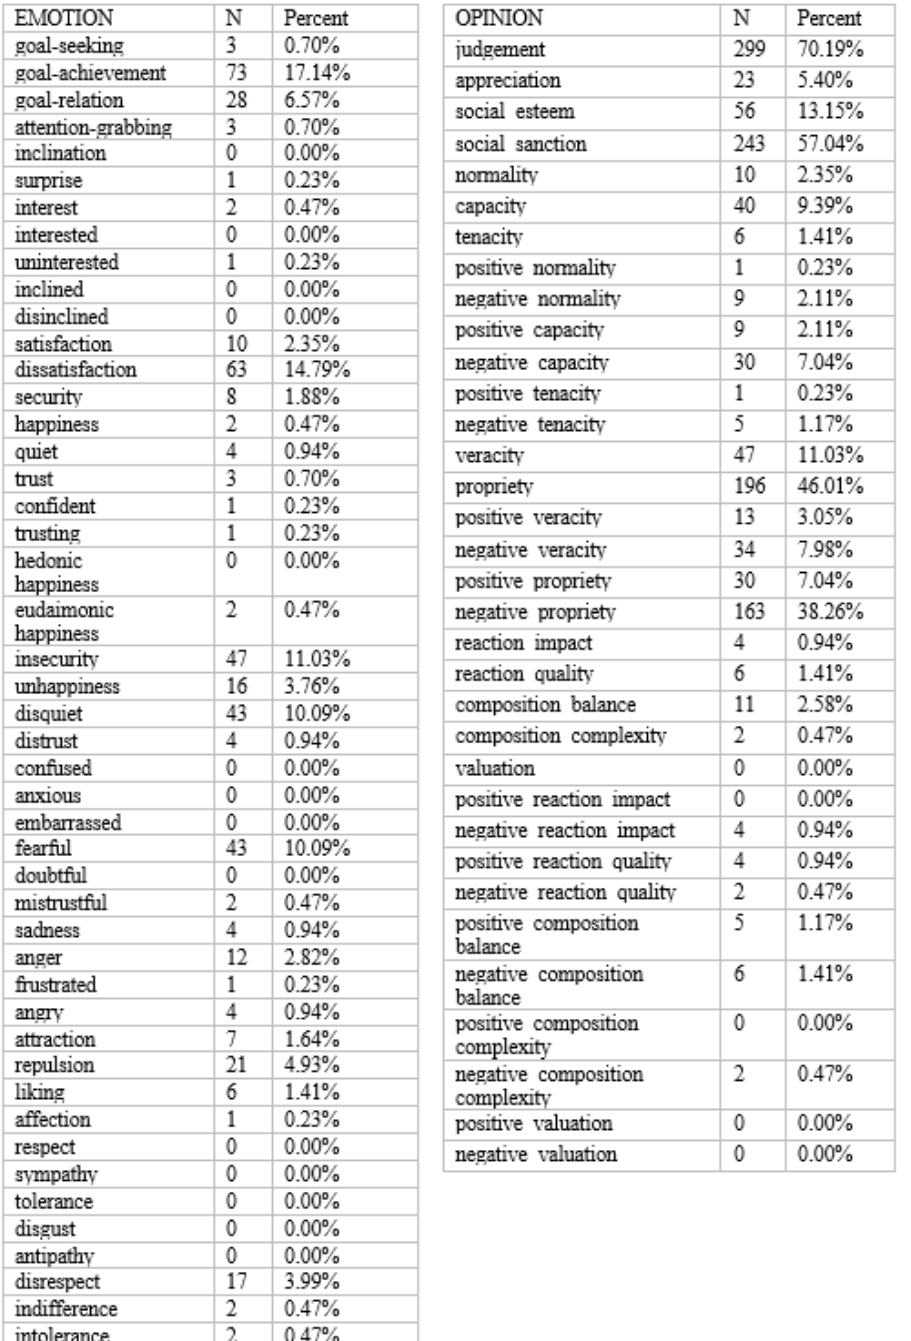
Figure A2. EMOTION and OPINION categories in the corpus of analysed texts (the occurrences of the annotated evaluative items expressed in numbers and percentage).